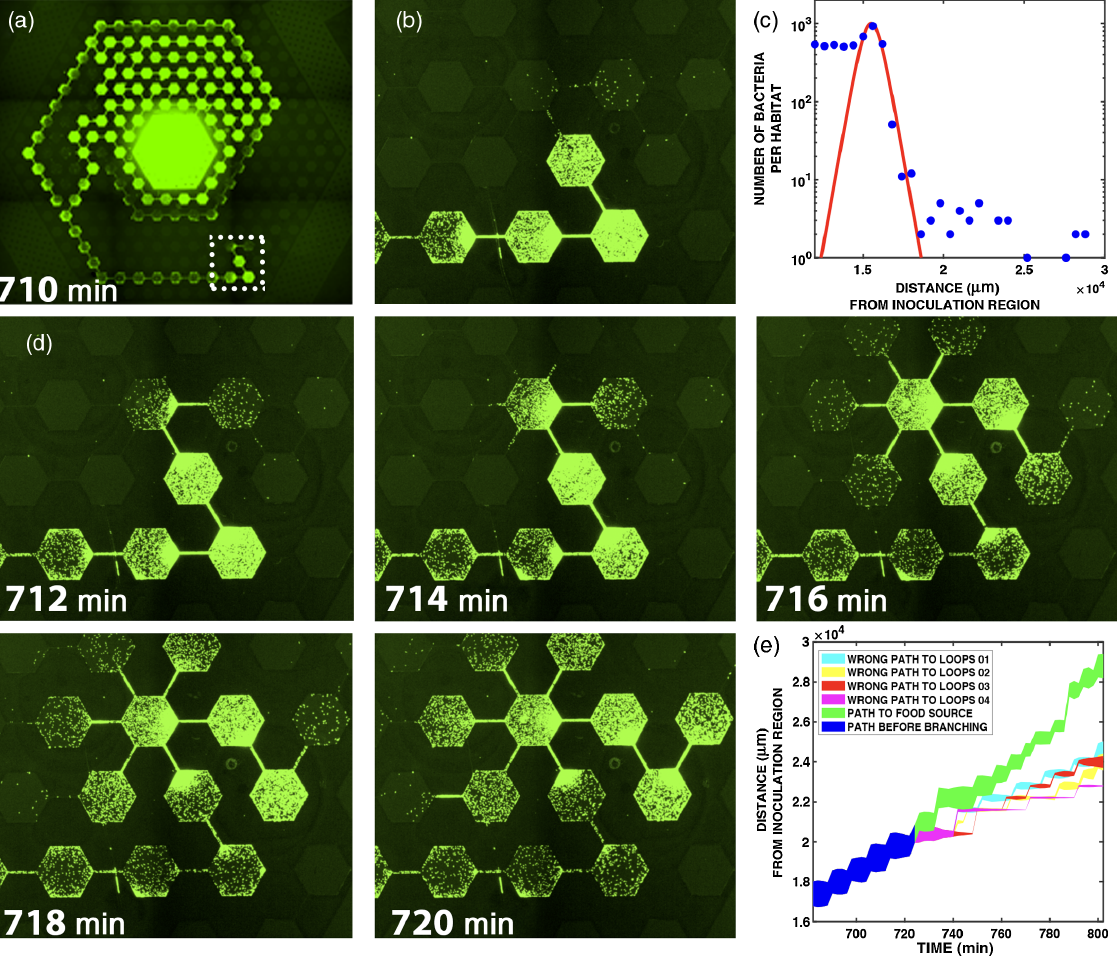
FIG. 4. (a) Inflow maze at t ¼ 710 min after inoculation. The dotted square is node C in Fig. 1. (b) Enlarged view of node C at 710 min. (c) Bacteria number per hexagon at t ¼ 650 min. The red line is a fit to the solitary-wave solution of the PKS equations: a sech 2 ð x Þ function [25]. (d) Sequence of the scattering of a wave as it enters and leaves node C , frames taken every 2 min. (e) Bacterial wave entry and exit populations in maze node C . The width of the line presents the bacteria density at the peak of the wave, the slope of the line indicates the wave